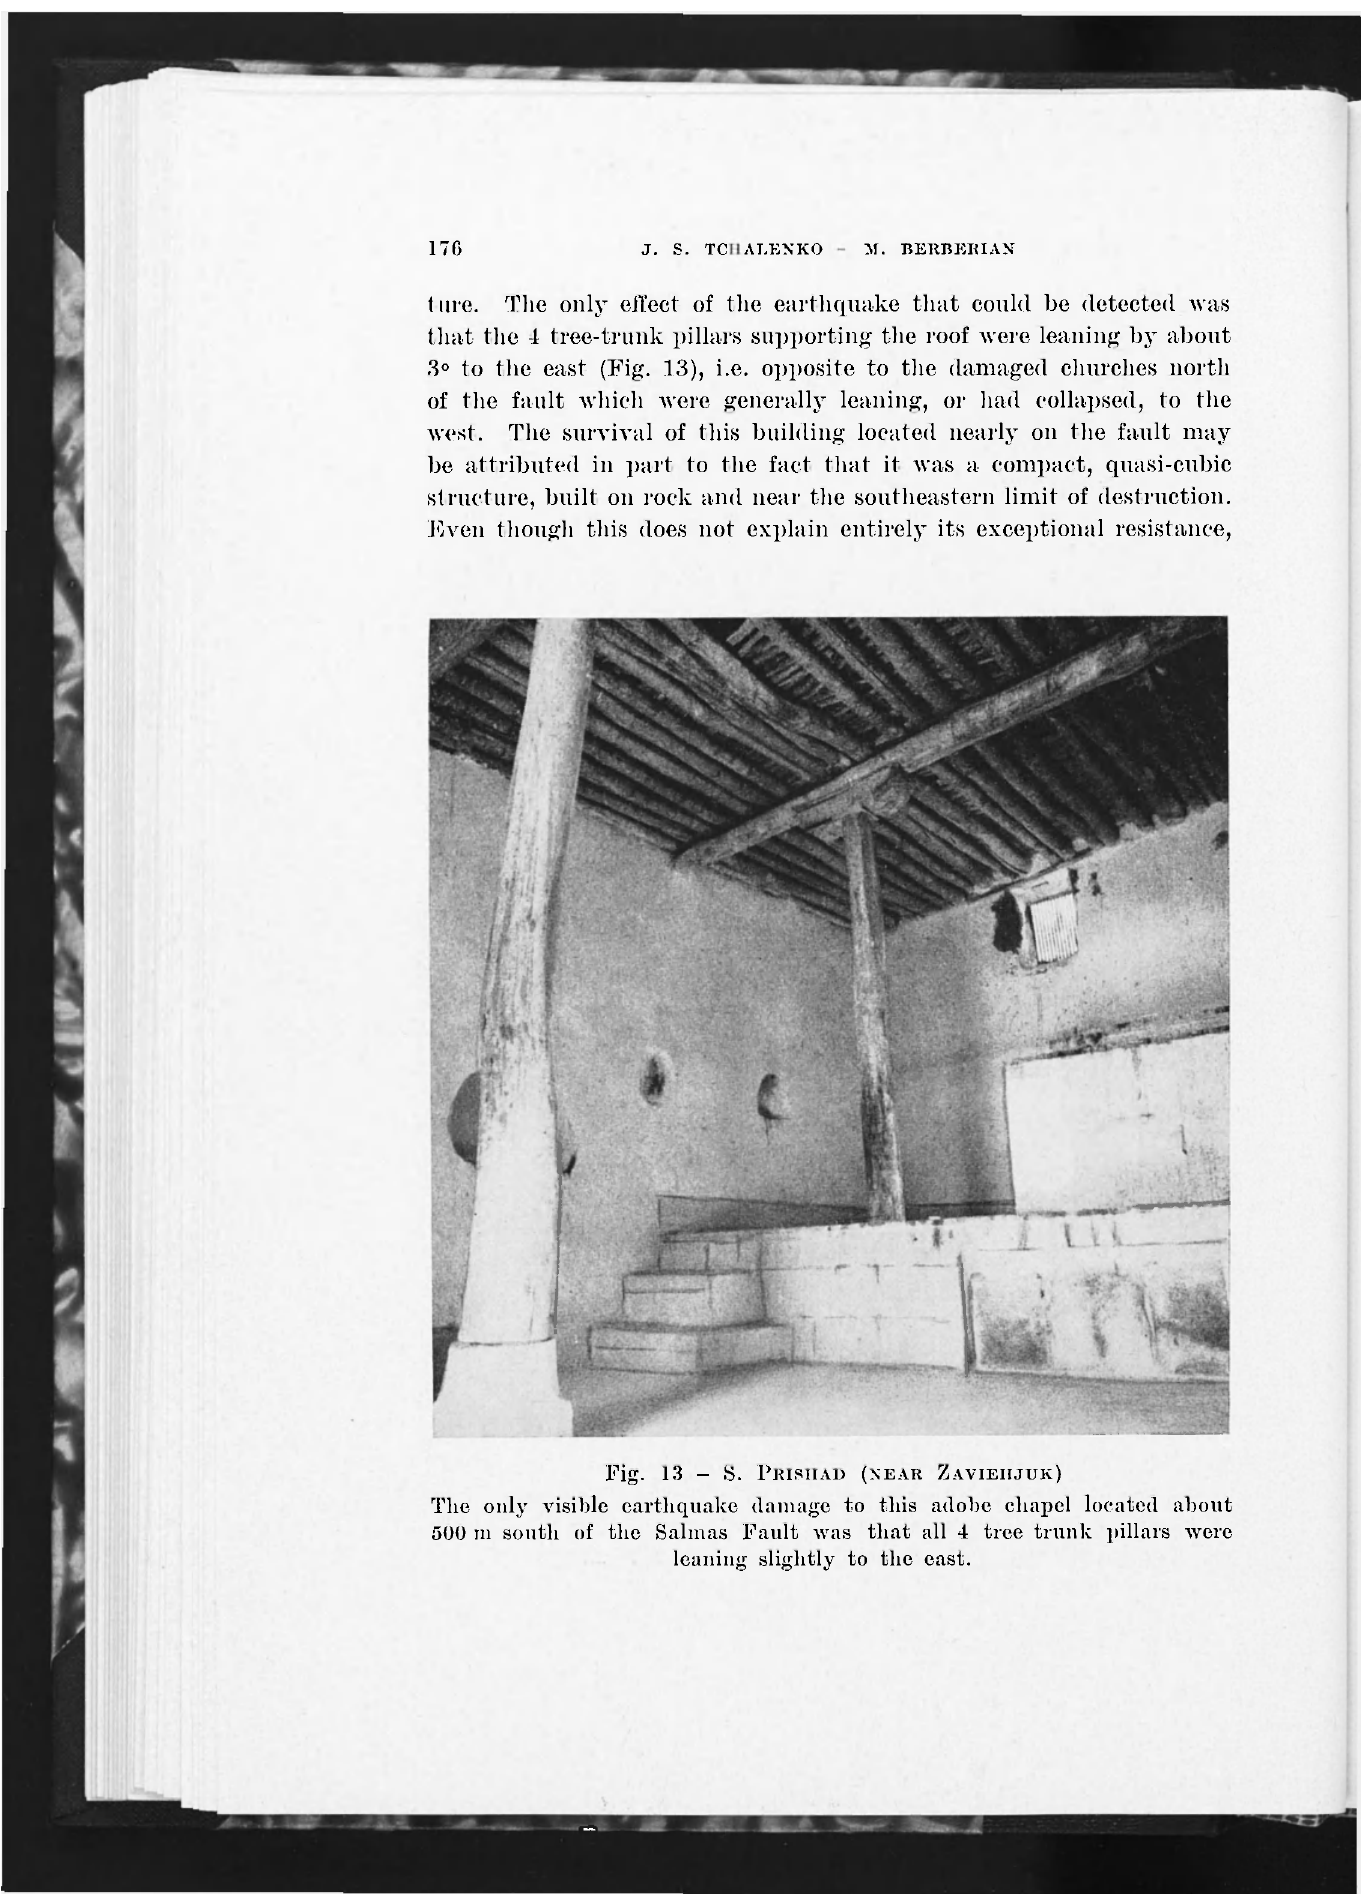
Fig. 13 - S. PRISHAD